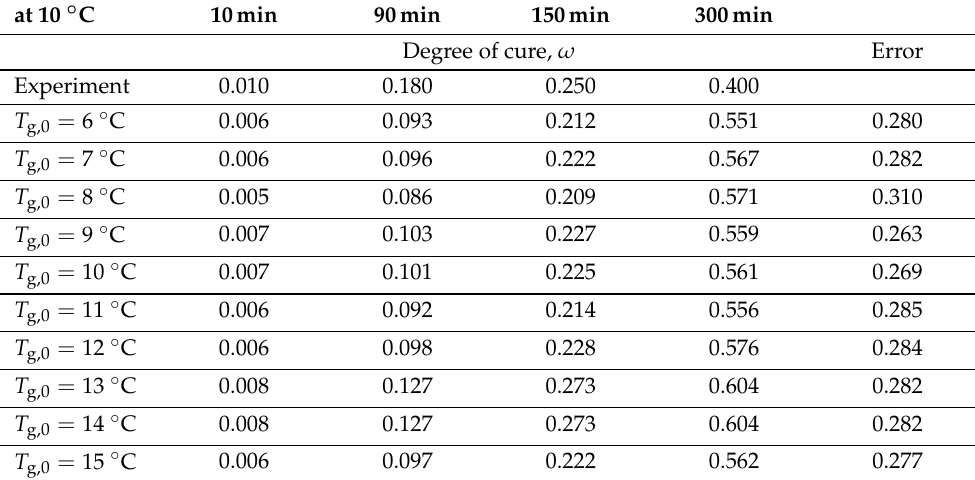
Table 3. Determination of T g,0 by an iterative